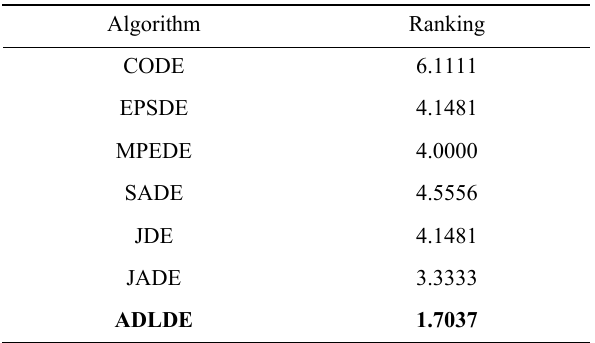
Table 10 Friedman test ranking when D =